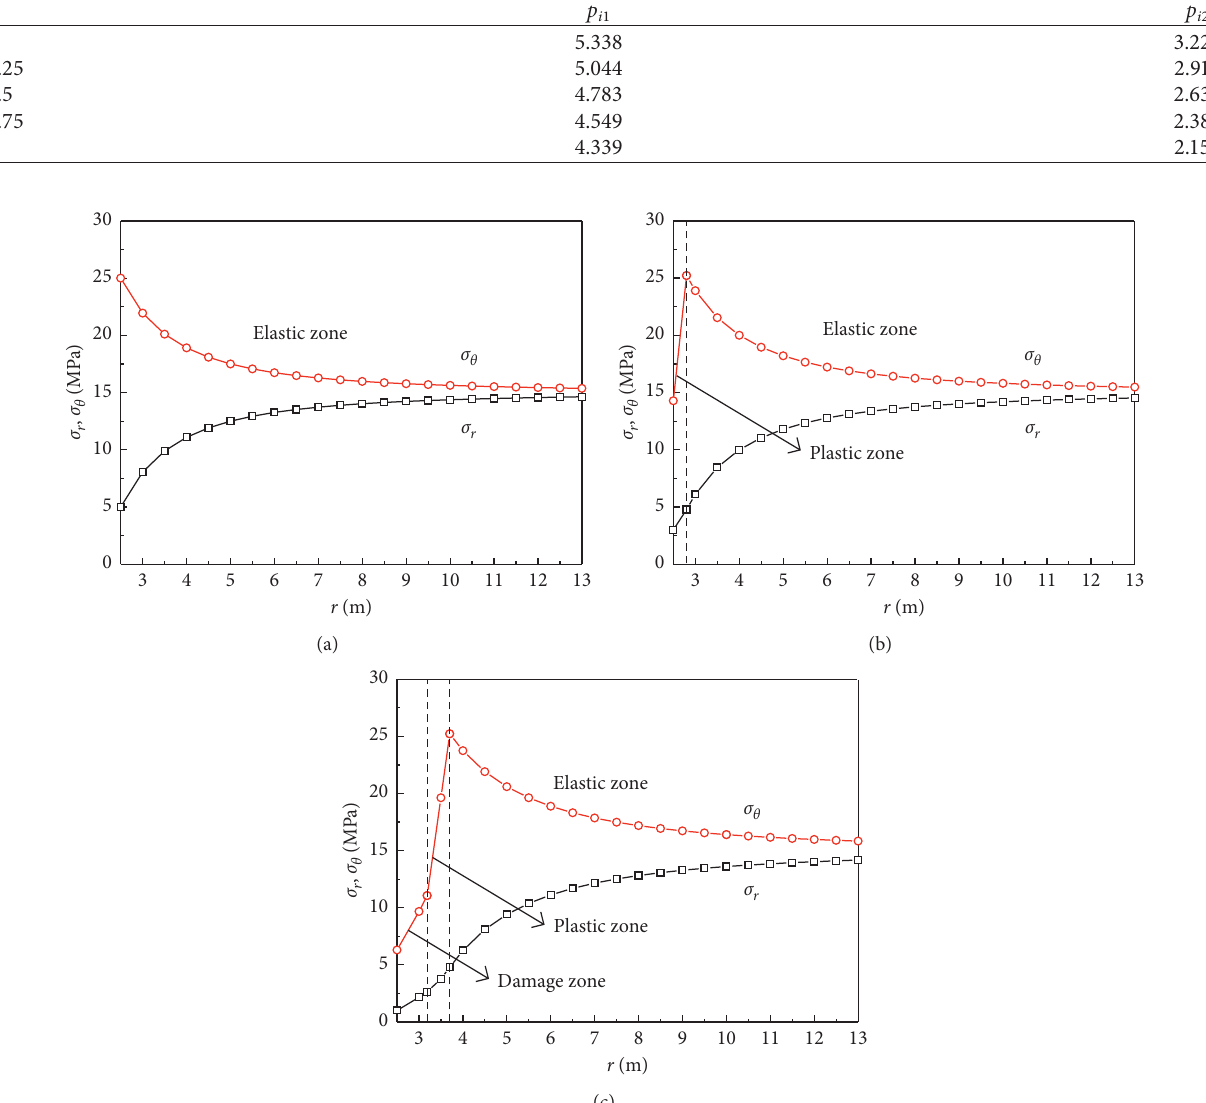
Figure 3: Stresses distribution under different support pressures. (a) p